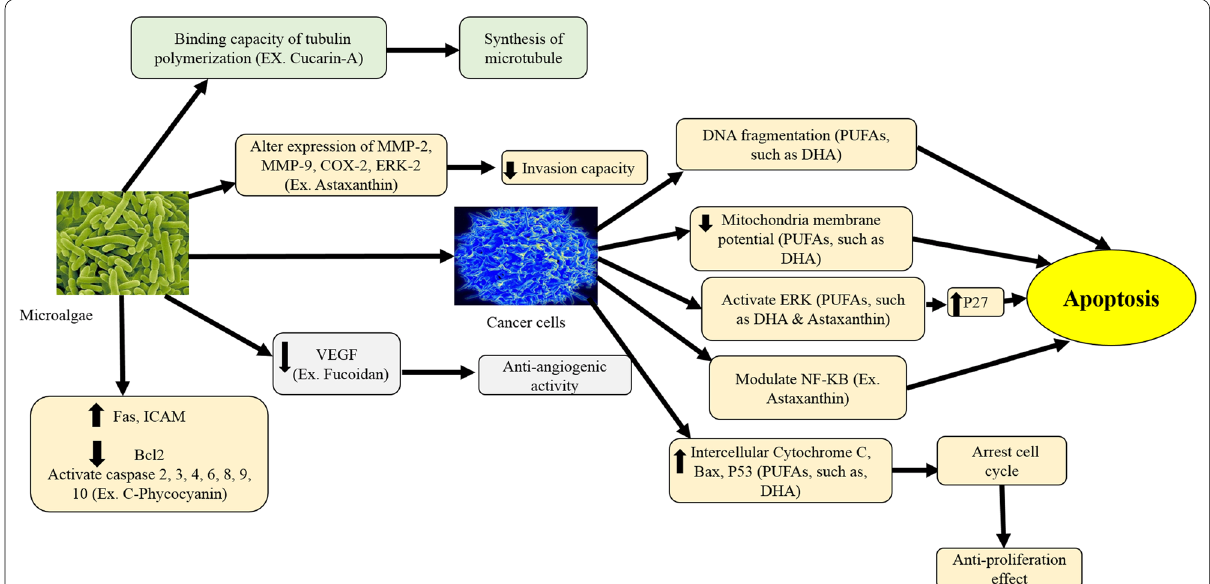
Fig. 4 The possible anticancer mechanism of microalgae (modified from El-hack et al. 2019, Microalgae in modern cancer therapy: